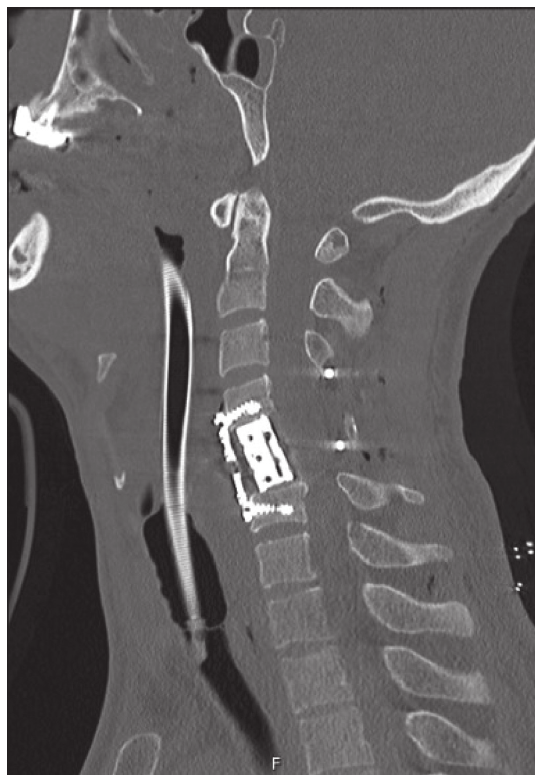
Figure 2: Computerized tomography image after surgical treat- ment by means of an anterior approach.